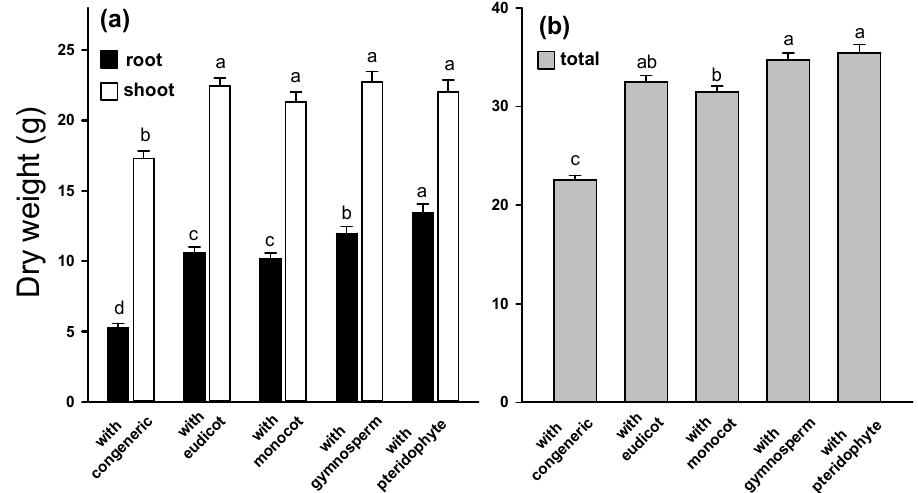
Figure 4. ( a ) Dry weight of roots (black bars) and shoots (white bars) and ( b ) Dry weight of total plant of Serianthes gran- diflora seedlings grown with different species. Treatments were: congeneric, Serianthes kanehirae ; eudicot, Tabernaemontana pandacaqui; monocot, Pogonatherum crinitum ; gymnosperm, Cycas nitida ; pteridophyte, Pityrogramma calomelanos . Bars rep- resent one SE ( n = 6) and bars with the same letters are not significantly different. same letters are not significantly